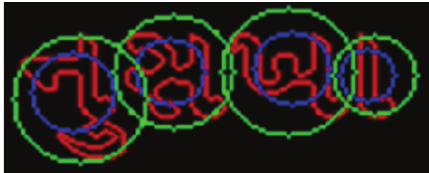
Figure 6: Computation of circularity of component on Gujarati script using fitted circles (blue: minimum encapsulating and green: best fitted).